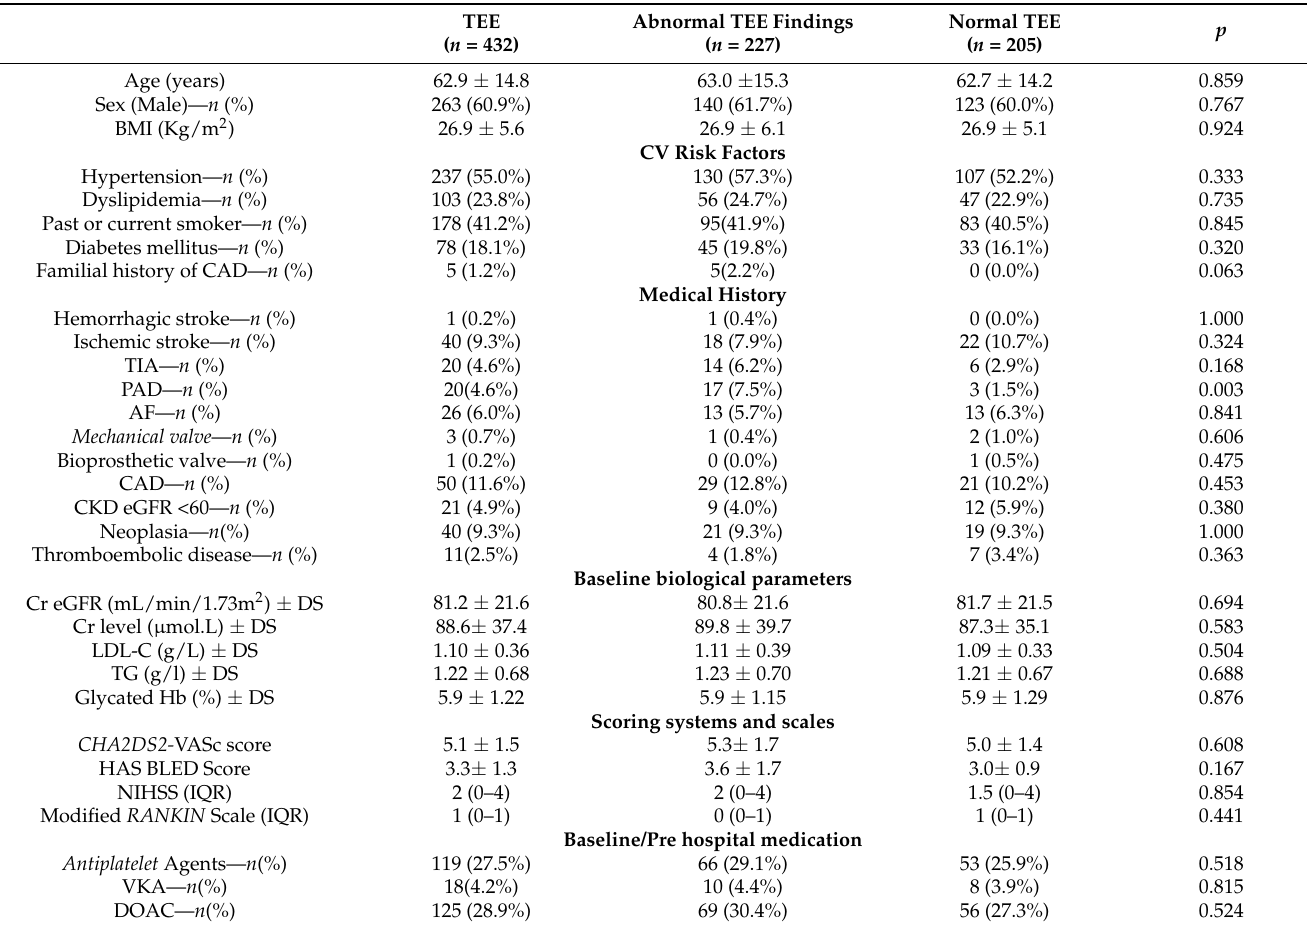
Table 4. Patients Characteristics according to Considered Potential Cardiac Source of Embolism in Transesopha- geal